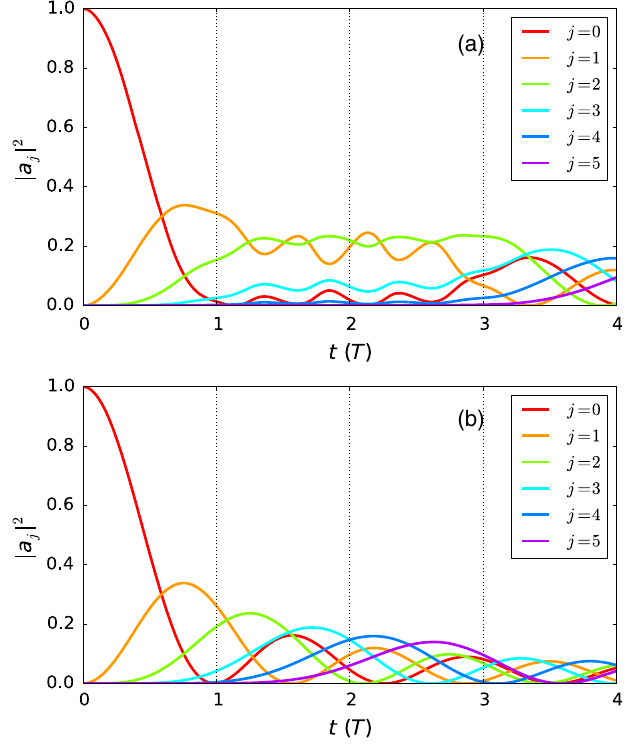
FIG. 7. (a)Evolutionofthe a coefficientsintimefor j ¼ 0 ; 1 ; … ; 5 j for band-structure and laser-pulse parameters as in Fig. 3(a).